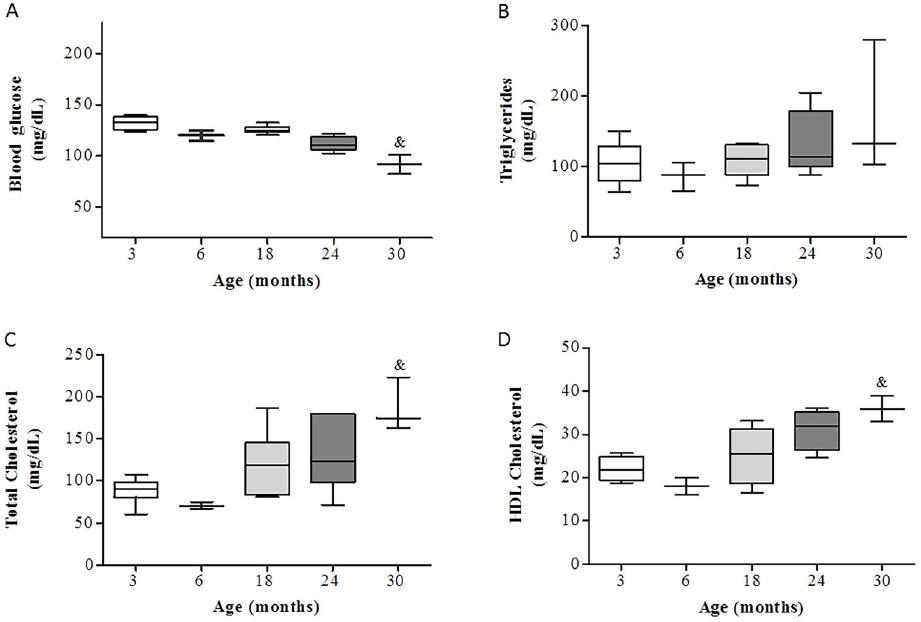
Figure 2. Blood glucose ( A ), triglycerides ( B ), total cholesterol ( C ), and high-density lipoprotein (HDL) cholesterol ( D ) of Wistar rats of different ages. Data are reported as medians and 10 – 90% interquartile ranges. & P o 0.05 compared to all groups (Kruskal-Wallis test followed by Dunn ’ s post hoc